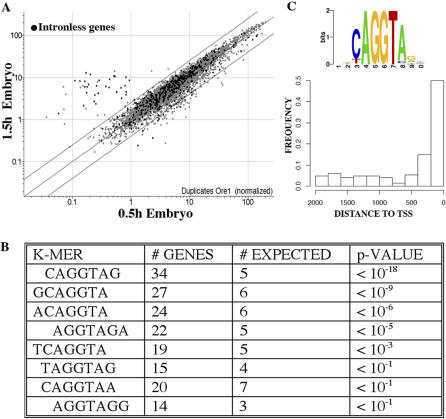
The Activation of the Zygotic Genome Starts from Intronless Genes Sharing the CAGGTAG Motif(A) Expression profile of freshly fertilized eggs (0.5 h, average of two biological replicates) compared to 1.5-h embryos (cycle 10–12, post-pole cell formation; average of two biological replicates). A group of 59 genes is significantly up-regulated at 1.5 h. Intronless genes are shown in black. About 70% of the up-regulated genes do not contain introns.(B and C) Identification of the CAGGTAG motif within the 2-kb upstream regions of the 59 genes up-regulated in (A). (C) Distribution of distances between CAGGTAG occurrences and the transcription start site of the early zygotic genes.